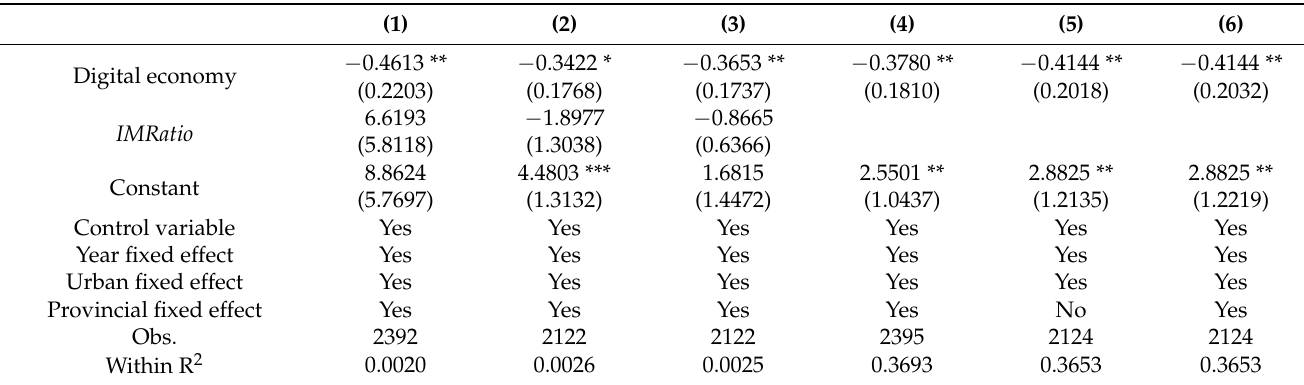
Table 4. Endogenous test